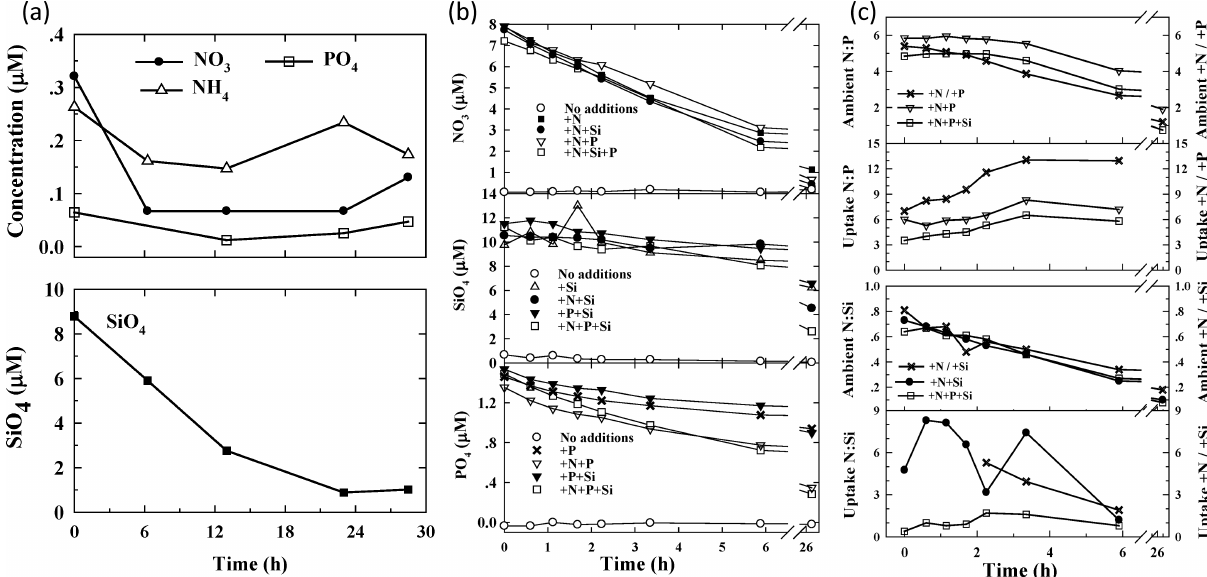
Figure 9. Time course of ambient NO − , PO 3 − and SiO − during the field incubation of a water sample taken at Station S1 on 4 June 1990; 3 4 4 (a) pre-incubation: no nutrients were added to the sample during the first 28h; (b) after pre-incubation, nutrients were added in eight treatments: + N, + P, + Si, + N + P, + N + Si, + P + Si and + N + P + Si, as described in the materials and methods section; (c) ambient nutrient ratios were calculated from measured ambient nutrients during the time course of incubation in panel (b) . Ambient + N / + P indicates the ratio of N in + N (the added N alone) over P in + P (the added P alone). Please note that this N:P ratio is not for N and P in the same bottle. Similarly, ambient + N / + Si indicates N in + N over Si in + Si (the added Si alone). The accumulative uptake ratio was directly calculated from the decreasing concentrations over time in panel (b)